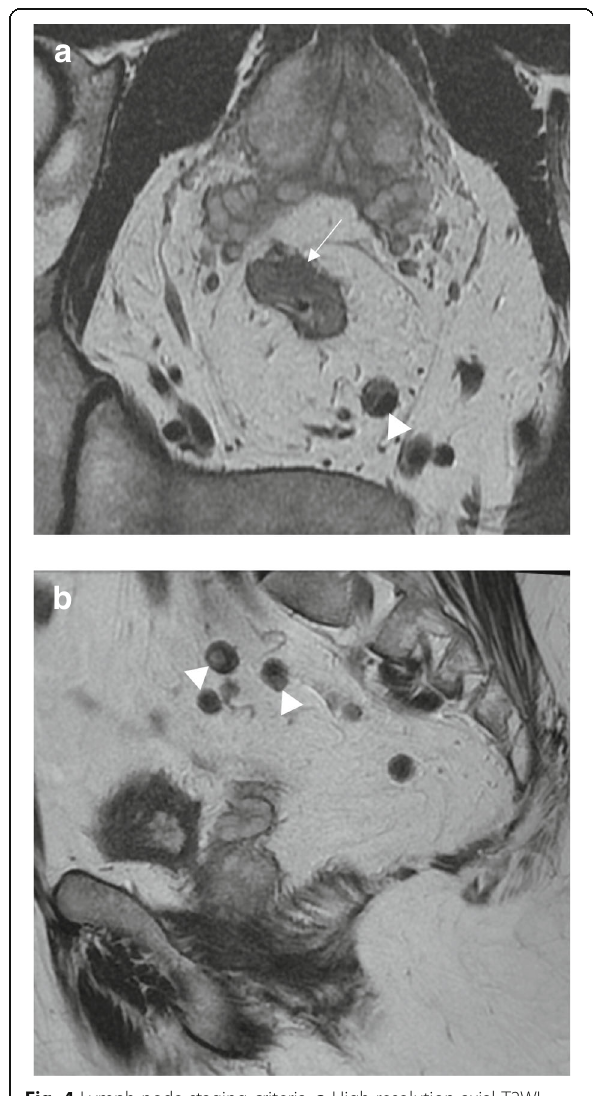
Fig. 4 Lymph node staging criteria. a High-resolution axial T2WI shows a semiannular anterior tumor (arrow) and a mesorectal involved lymph node showing mixed signal intensity (arrowhead). b High- resolution sagittal T2WI shows other involved lymph nodes with mixed signal intensity (arrowheads)